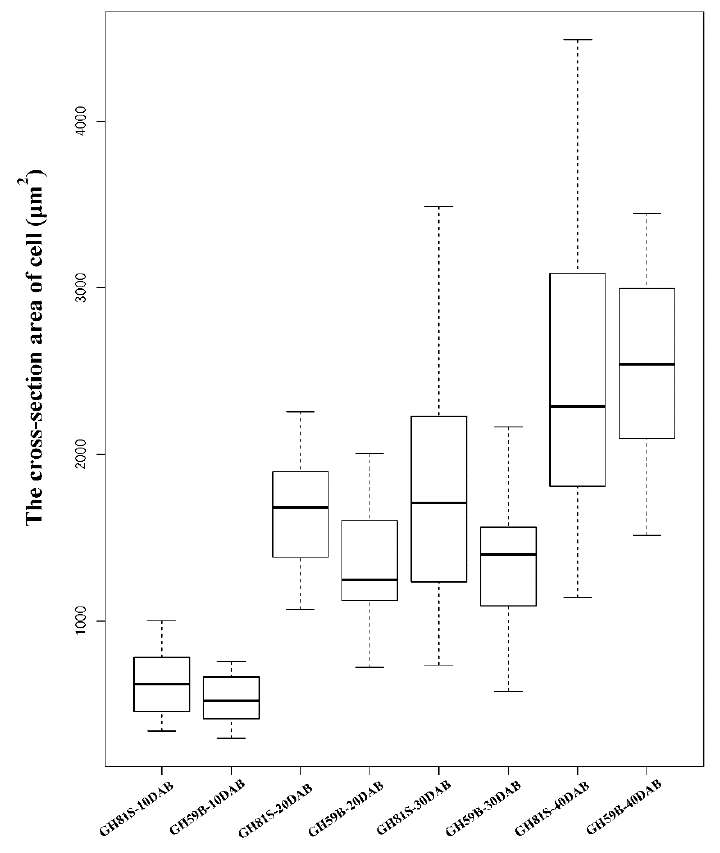
Figure 2. The cross ‐ section area of cell size of ‘GH81S’ and ‘GH59B’ in 40 days after blossom. Figure 2. The cross-section area of cell size of ‘GH81S’ and ‘GH59B’ in 40 days after blossom.